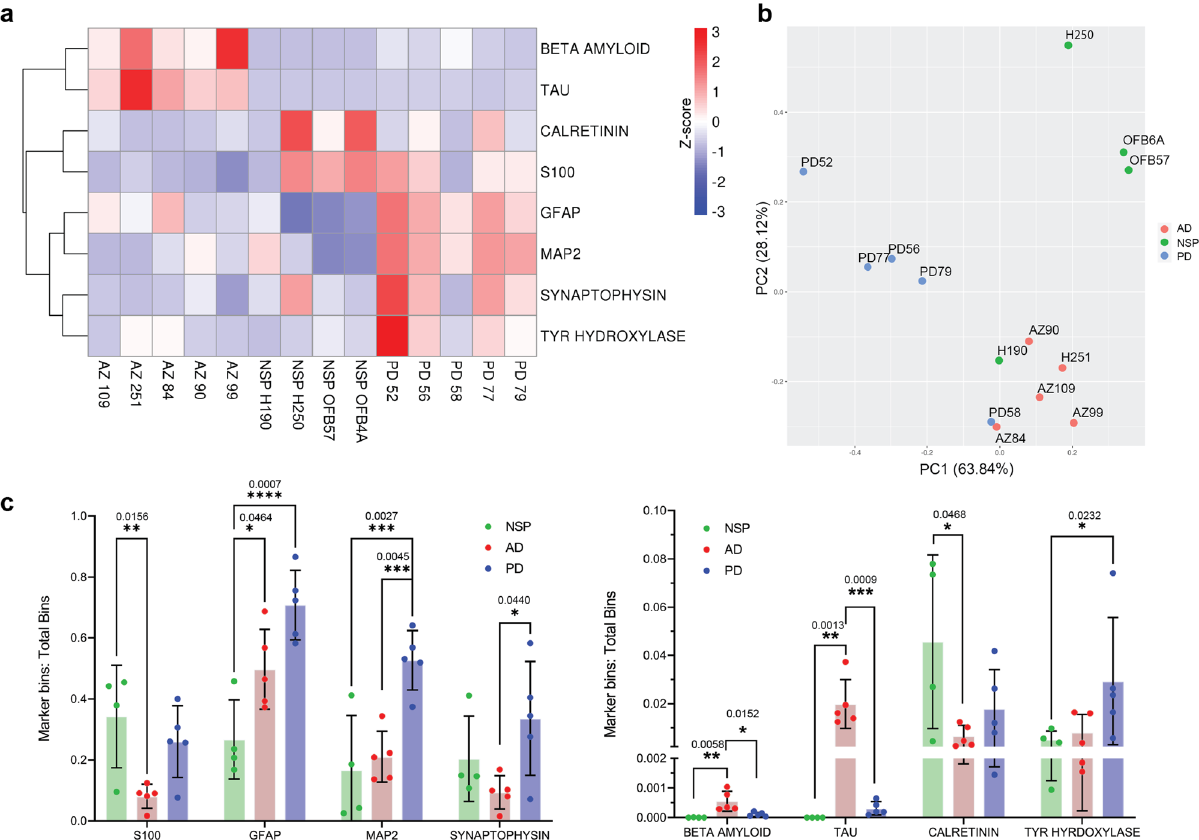
Fig. 5 Analysis of differentially expressed markers between NSP, AD and PD bulbs. The ratio of labelled bins to total bins was determined for each marker and each case. Markers were determined to be differentially expressed based on an uncorrected ANOVA P value < 0.1. a Heat map of the ratio of labelled bins to total bins for differentially expressed markers for each case. b PCA scatterplot of cases coloured by group identity. c Graph of labelled bins to total bins ratio per case for differentially expressed markers, n = 4 NSP cases, 5 AD cases and 5 PD cases. Error bars are standard deviation of ratio for each case within the group. * P ≤ 0.05, ** P ≤ 0.01, *** P ≤ 0.001, **** P ≤ 0.0001. Exact P values are stated above the comparison.